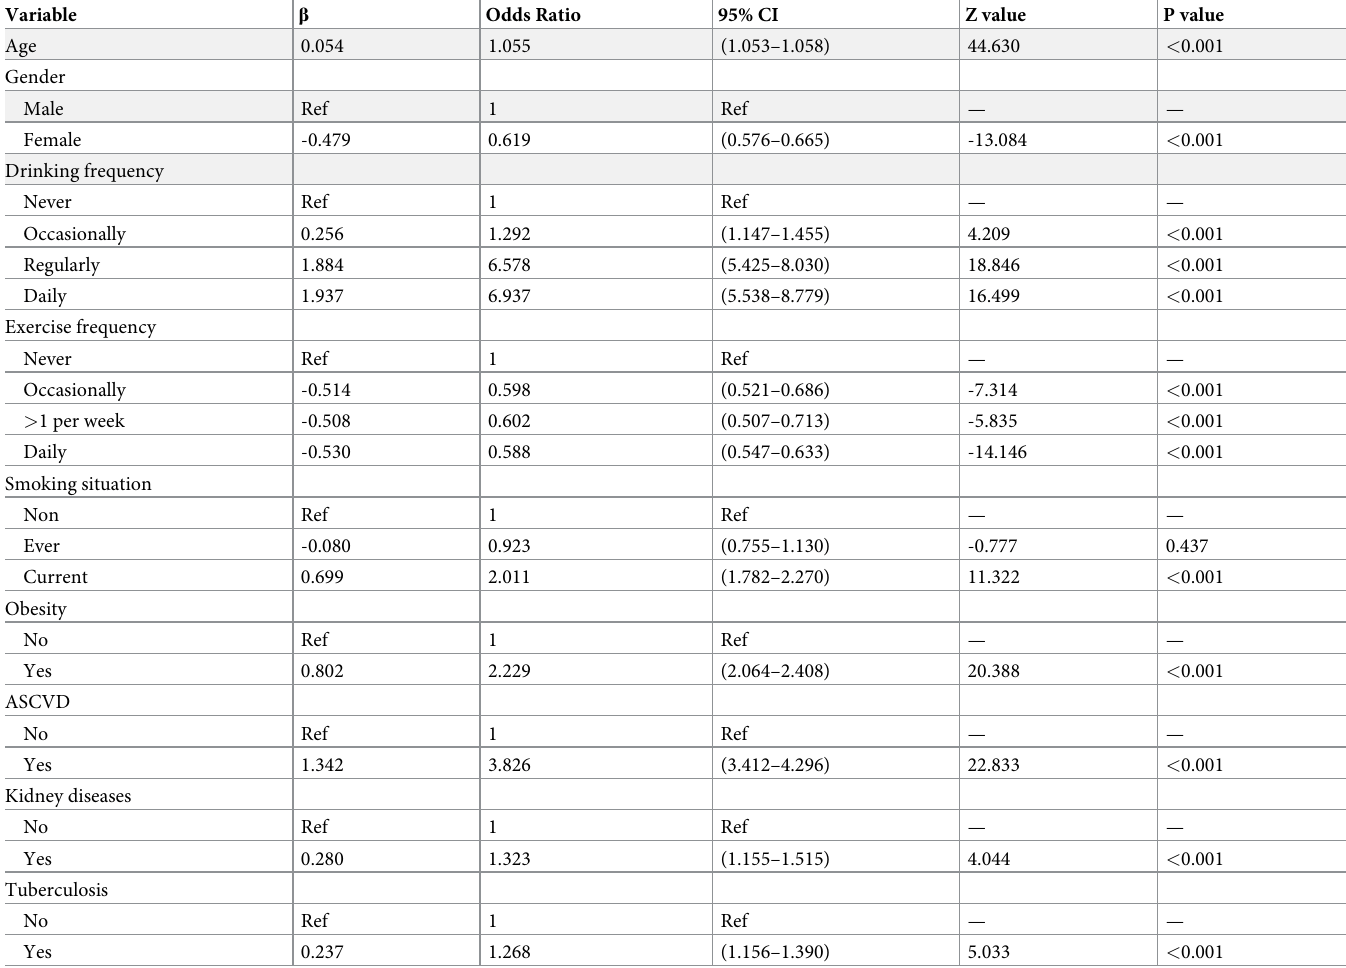
Table 2. Multivariate logistic regression analysis for risk factors associated with hypertension in the training cohort (N =